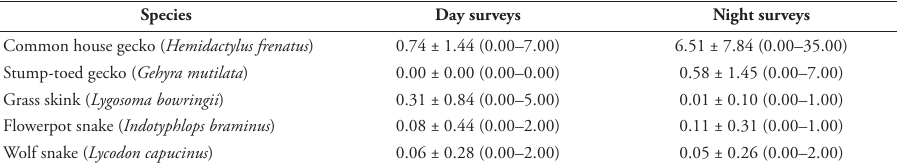
Table 2. Summary of the counts (number of observations per each 10-minute survey) of five species of alien reptiles on Christmas Island across the 34 survey sites (mean ± standard deviation, and range). Three repeated surveys were conducted during each day and night time conditions in each survey site. The raw data are available at